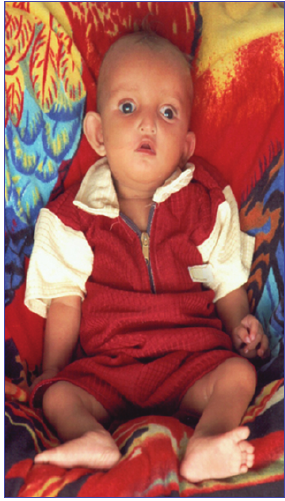
Figure 1: Depicting phenotypes of Case 1.